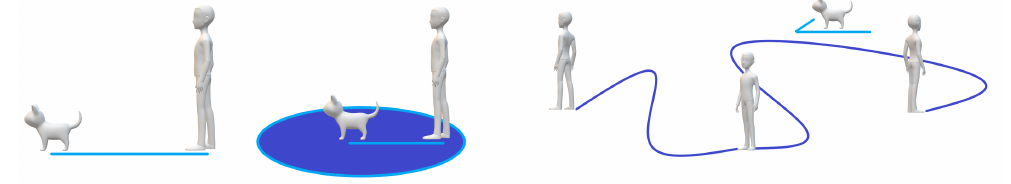
Figure 1. The different following mechanisms. Left : Limited. The user’s position is limited behind the guide (the cat in the figure). Middle : Semi-limited. The user is allowed to walk around the guide (in the blue circle) but will be automatically moved to the near-guide position if the user is far from the guide. Right : Not limited. The user can freely move anywhere in the virtual